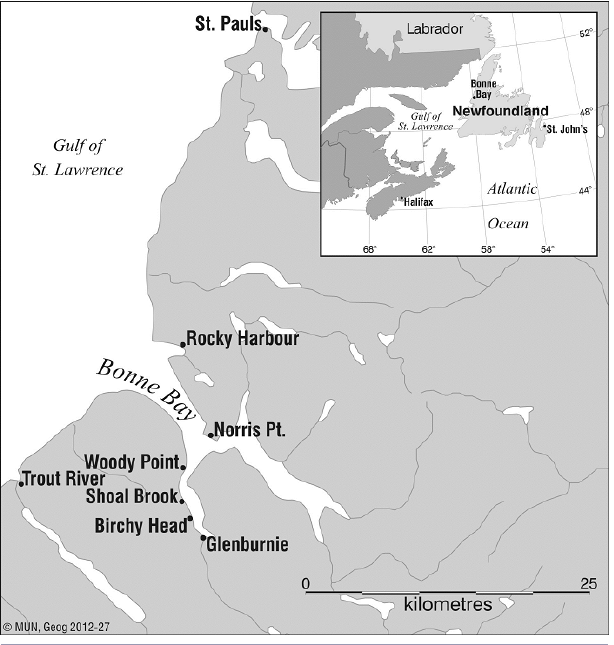
Fig. 1 . Map of the Bonne Bay region (Lowett